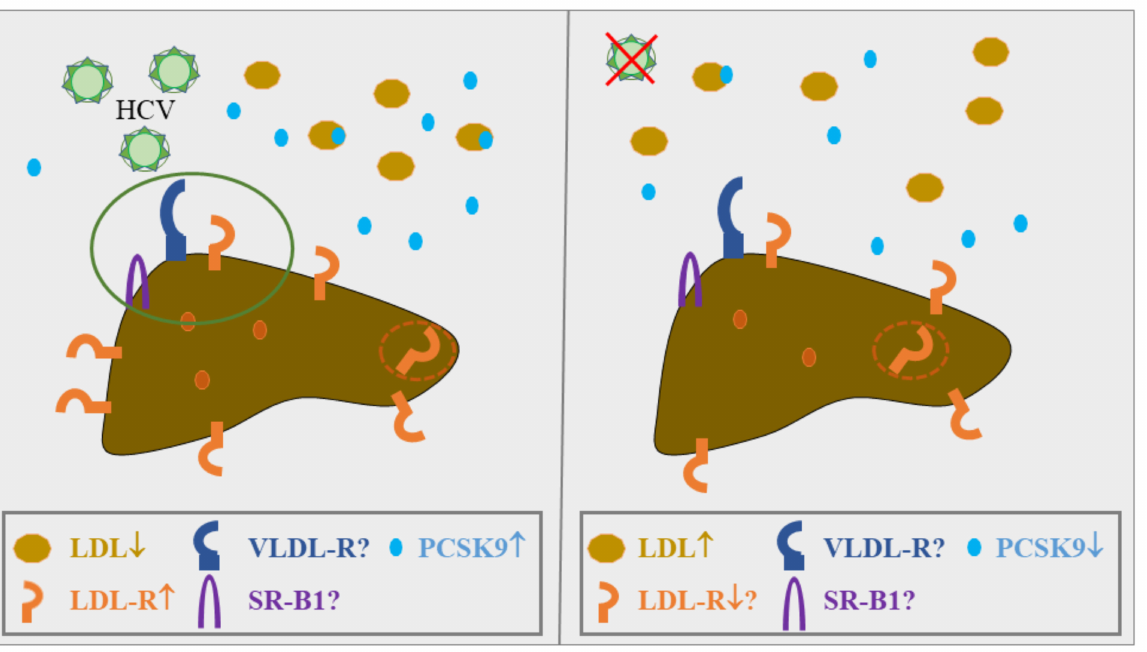
Figure 2. Regulation of LDL, LDL-R and PCSK9 in HCV. HCV infection is associated with high hepatic LDL-R levels and low amounts of circulating LDL, while hepatic and circulating PCSK9 levels are upregulated [31,124,125,127,129]. HCV infection of cells occurs via the LDL-R, the VLDL-R and SR-B1 [118] (encircled in green) and thus, PCSK9 blockage and the associated upregulation of the LDL- R and the VLDL-R was proposed to increase HCV infection [137]. Whether VLDL-R and SR-B1 are also high in the HCV-infected liver has yet to be clarified. Moreover, LDL-R levels were determined by immunoblotting of whole-liver extracts, which cannot discriminate between cell surface-exposed and intracellular LDL-R protein (orange circle with broken lines). However, the decline of LDL argues for a higher functionality of the hepatic LDL-R. Efficient elimination of HCV rapidly increased circulating LDL, whereas PCSK9 levels most likely decline [126,128,129,131–136]. Hepatic expression levels of LDL-R, PCSK9, VLDL-R and SR-B1 after viral eradication are still